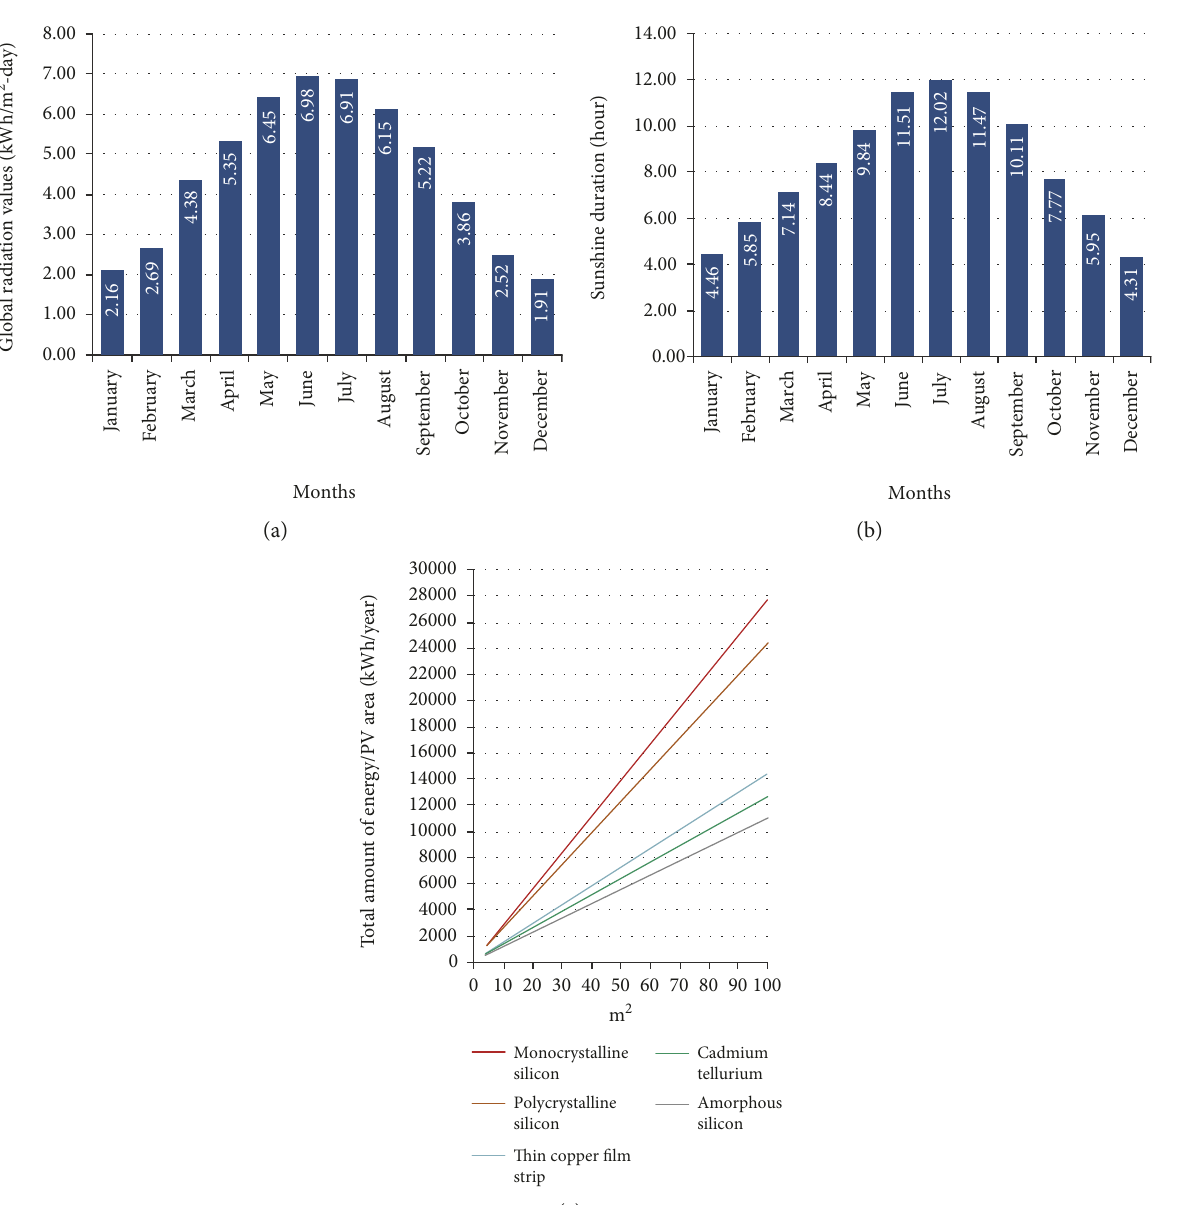
Figure 2: Karaman province (a) global radiation values, (b) sunshine duration, and (c) total amount of energy/PV